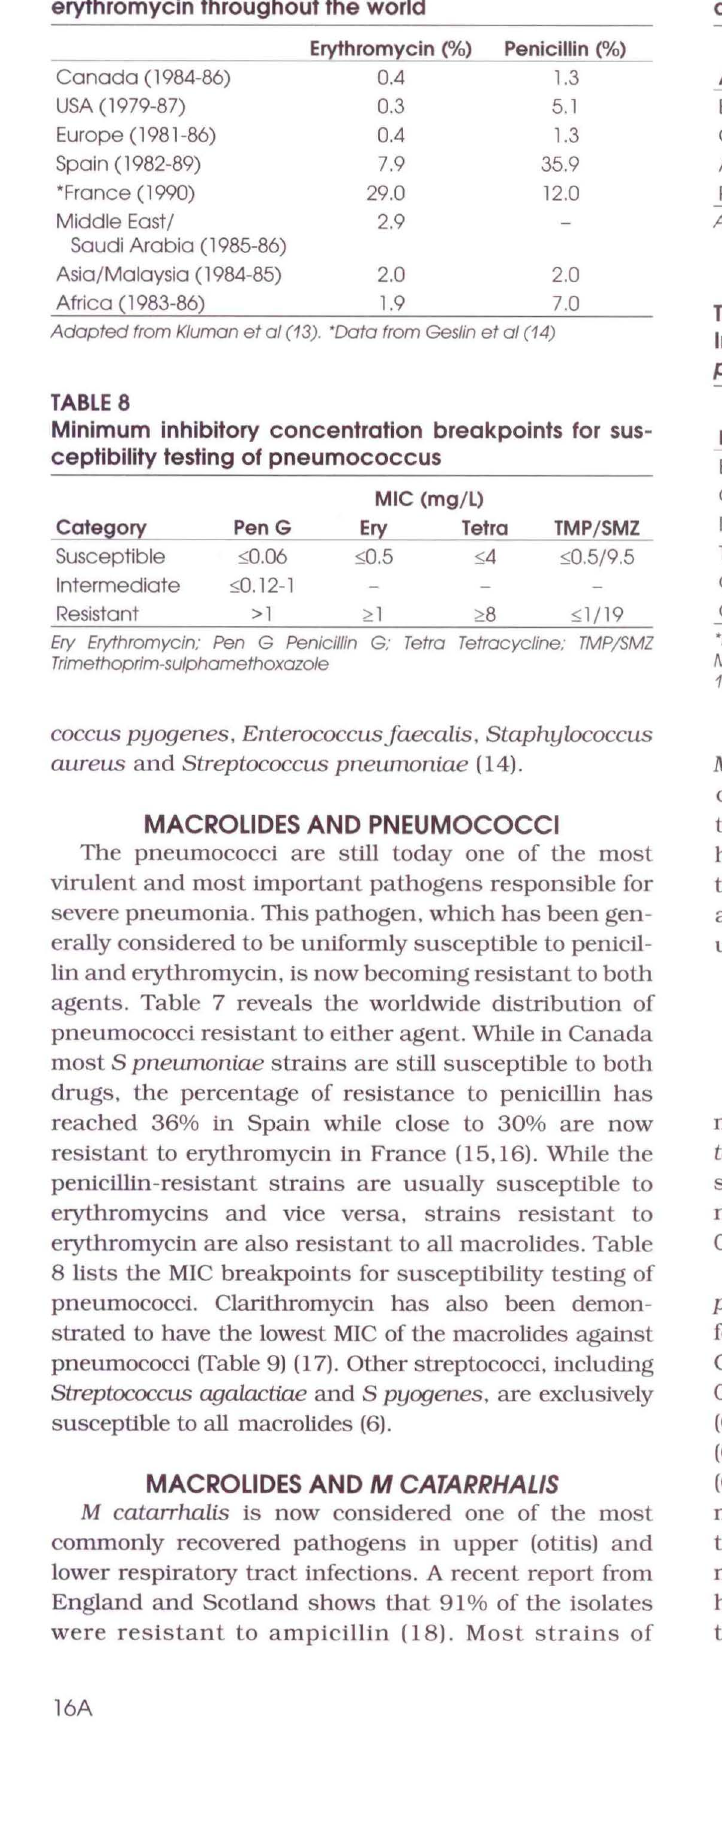
Resistance (%) of pneumococci to penicillin and erythromycin throughout the world